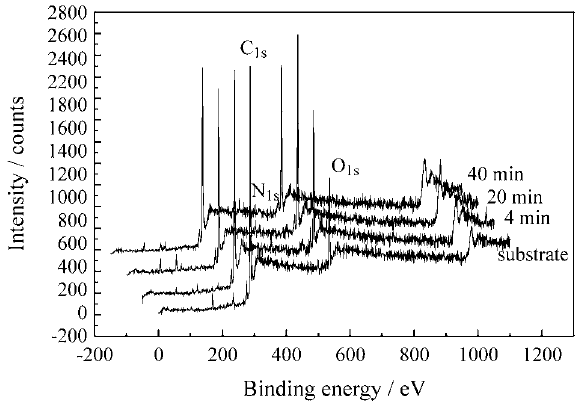
Figure 8. XPS survey scans of untreated and Ar treated membranes, during 4, 20 and 40 min at 5